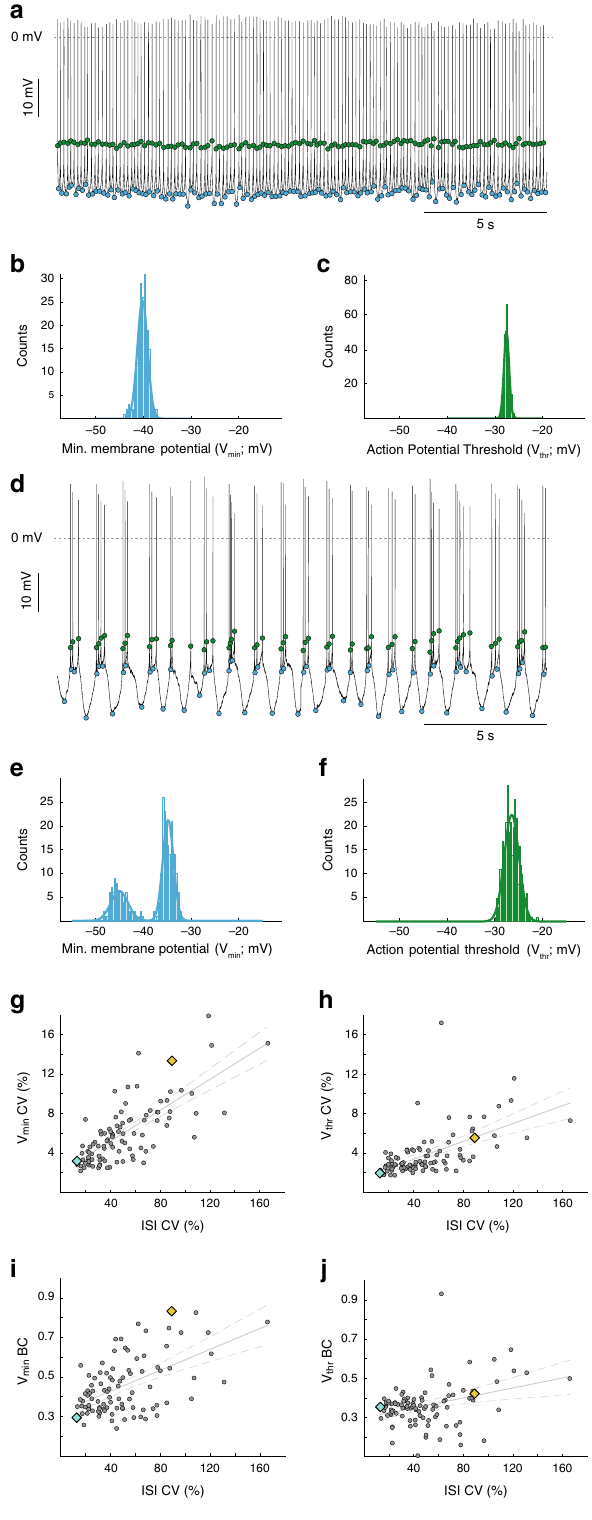
averaged trace (Fig. 3f, bold trace) portrays a low-variance sub- threshold signature with a ~400-ms gradual, ramp-like mem- brane potential depolarization of about 10 mV until reaching the action potential threshold. Figure 3g shows the narrow fi ring frequency distribution of this example cell. The frequency dis- tribution of the population of pacemaker dopamine neurons identi fi ed by their low BCs is shown in Fig. 3h. The spread of this